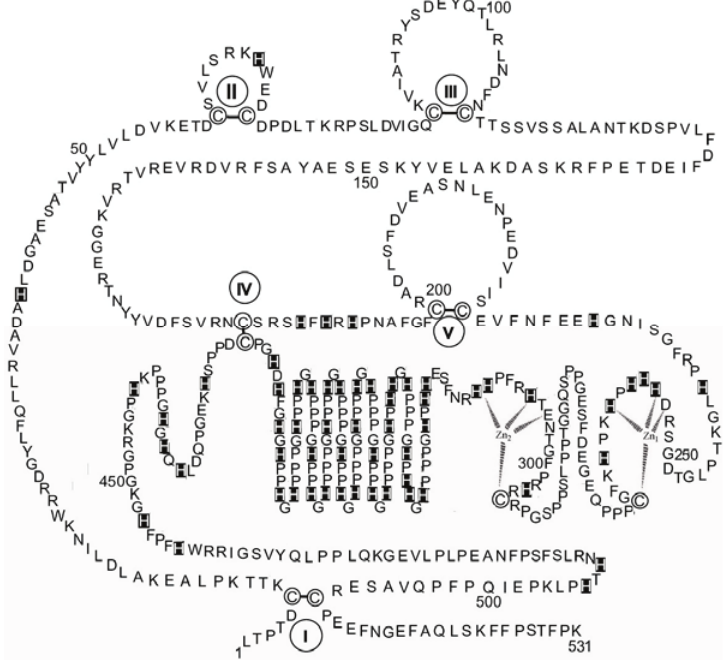
Figure 5. Hypothesis of a specific dinuclear zinc binding site in rabbit HPRG